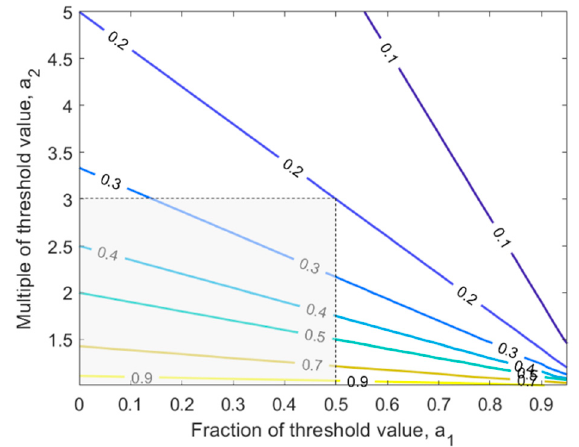
Figure 5. Isolines display the fraction of time when the threshold concentration may be exceeded in the cabin air (no more than threshold multiple), while in the remaining time the concentration remains below the threshold (no more than the threshold fraction). This ensures H&S standard compliance.